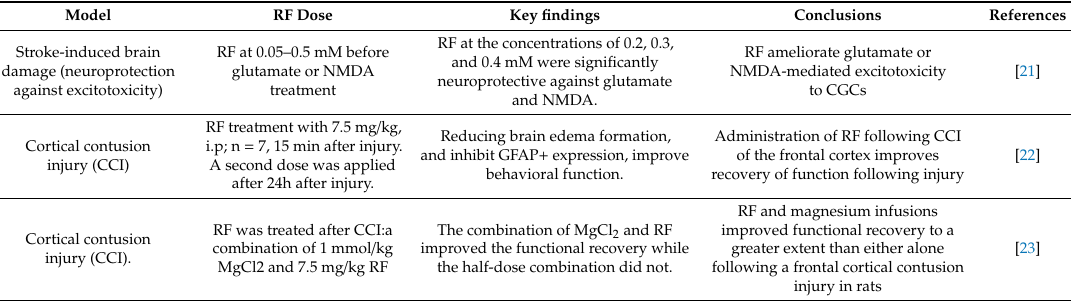
Table 3. Evidence of RF on the attenuation of reperfusion oxidative